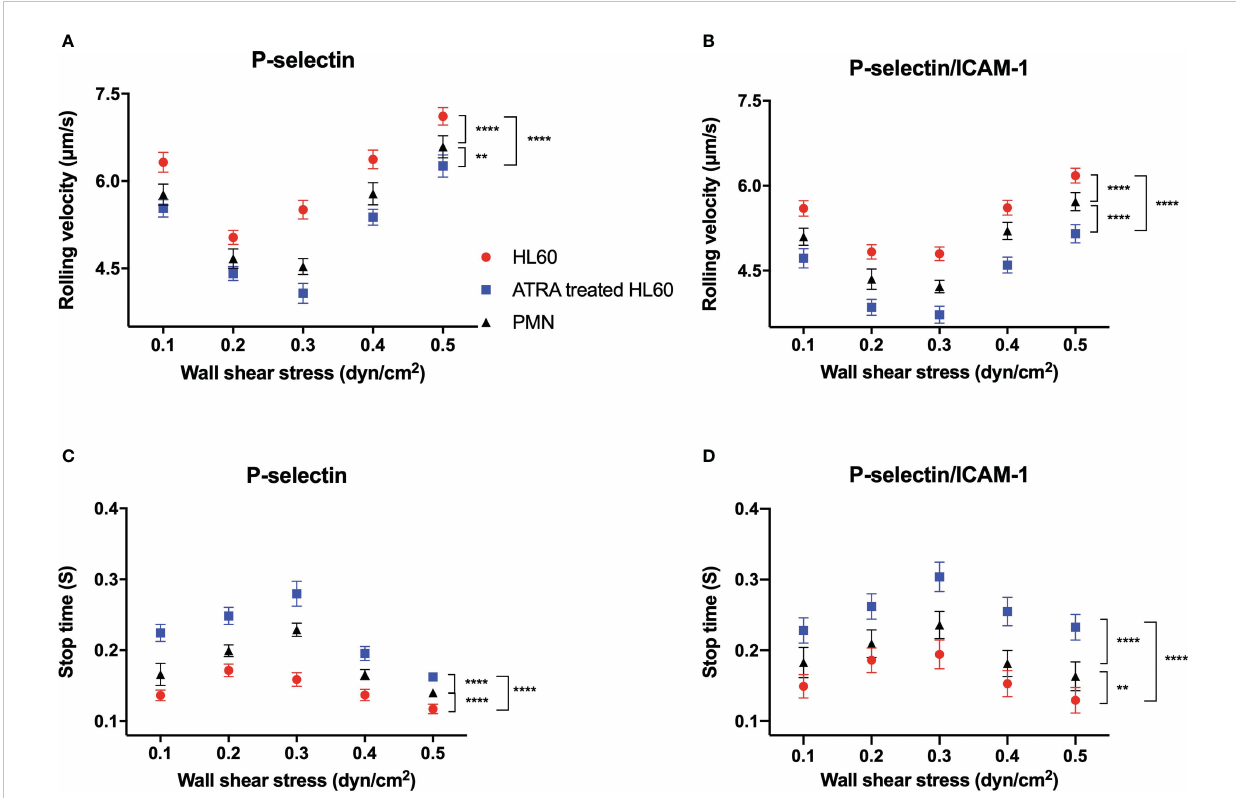
FIGURE 4 Variations of rolling velocity and stop time of cells on P-selectin alone or combined with ICAM-1 versus wall shear stress. Cell suspensions of neutrophils (black) and untreated (red) or all-trans retinoic acid (ATRA)-treated HL60 cells (1 × 10 -6 M, 120 h; blue) were perfused over substrates coated with 500 ng/ml P-selectin alone or plus 500 ng/ml ICAM-1 under various wall shear stresses. (A, B) Plots of the rolling velocity of cells on P- selectin against wall shear stresses with and without ICAM-1 engagement. (C, D) Stop time plots against wall shear stresses for cells on P-selectin in the absence and presence of ICAM-1. Data are presented as mean ± SEM and are represented by at least 100 events from three independent experiments. Statistical signi fi cance was analyzed by two-way ANOVA followed by Tukey ’ s multiple-comparisons tests, and the signi fi cant level of difference was shown by the P -value. ** P < 0.01, **** P <